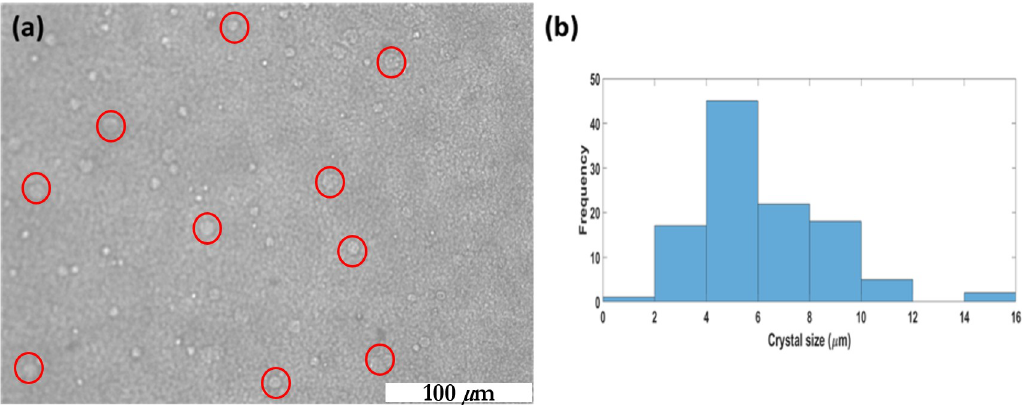
Fig 3. Analysis of crystal size distribution from a phase-contrast image : (a) Field of view under analysis (scale bar = 100 μ m). (b) Frequency distribution of crystal size distribution in a liquid